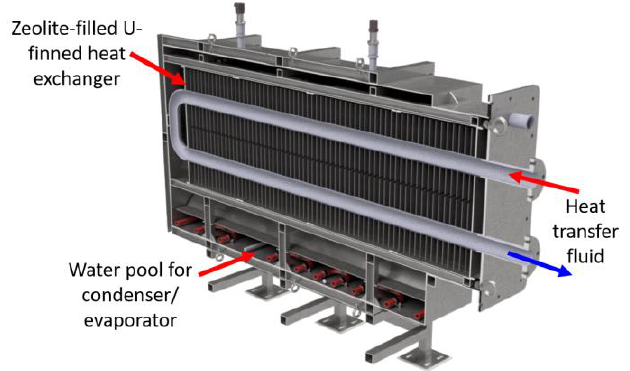
Figure 1. Midplane cross-section of reactor “all-in-one” configuration.